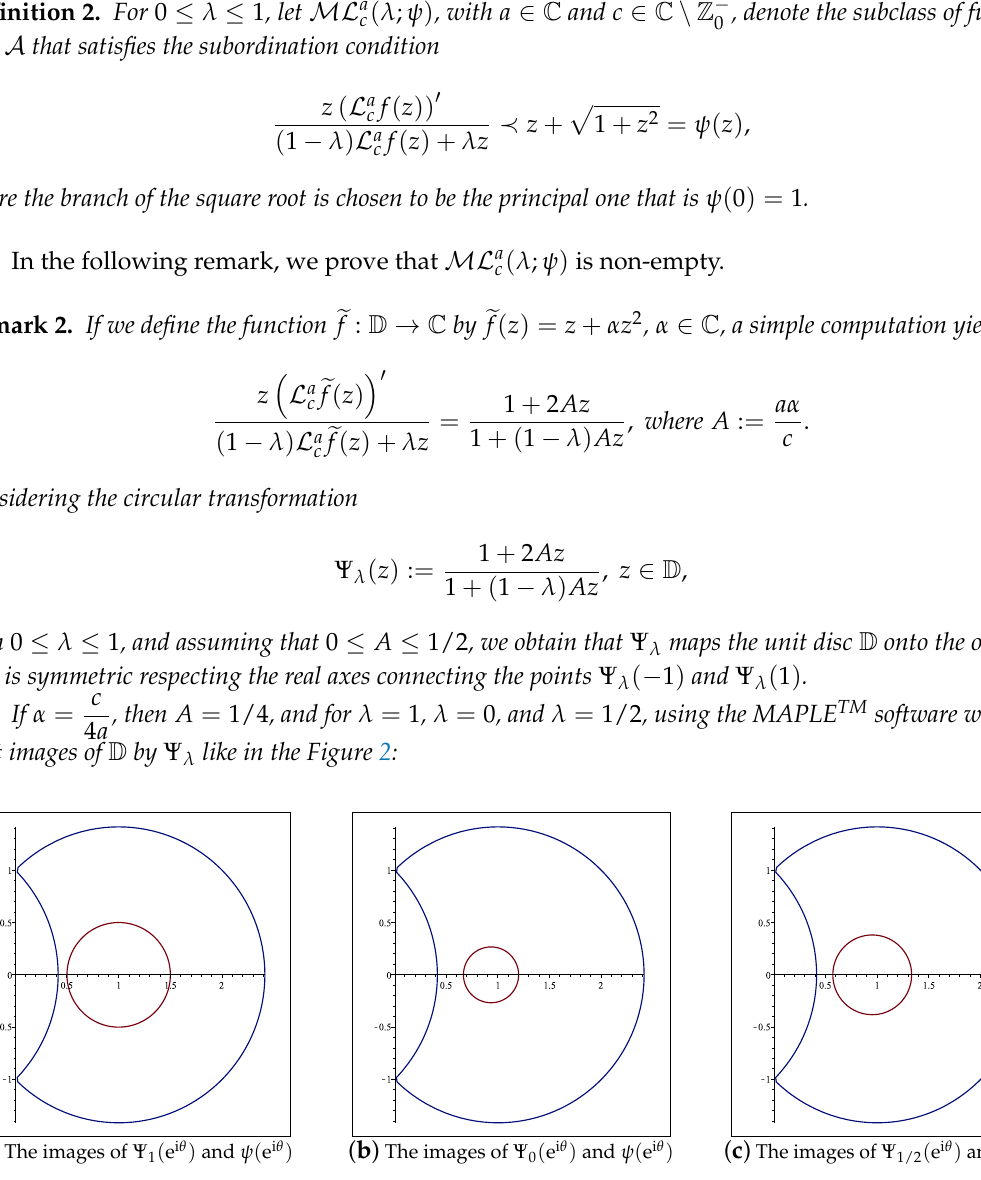
Figure 2. The images of Ψ λ ( e i θ ) and ψ ( e i θ ) , θ ∈ [ 0,2 π )